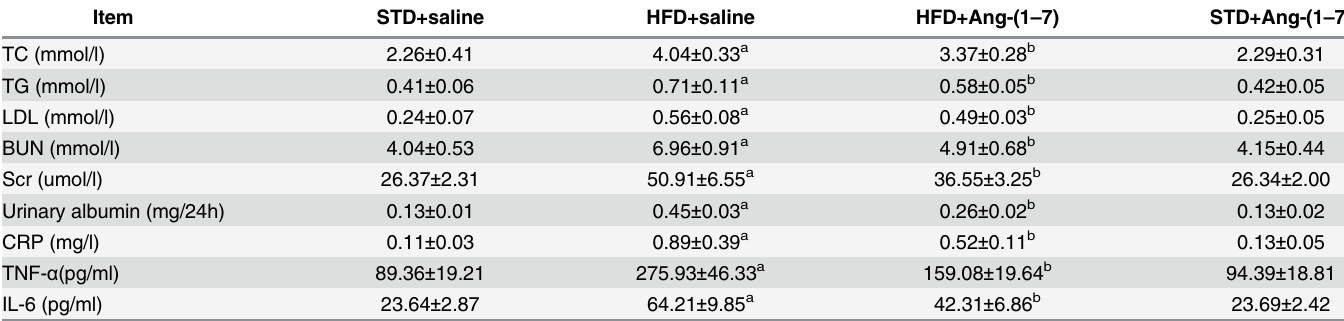
Table 1. Serum and urine biochemical